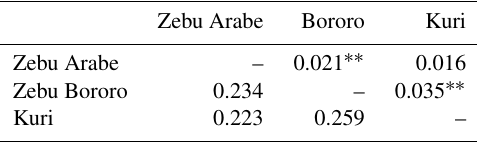
Figure 1. Distribution of allele sharing distance (IBS) between pairs of individuals. Distance was plotted separately where pairs were drawn from within the same breed (blue bars) and from across the breeds (red bars). Table 3. Pairwise allele sharing distance (lower triangle) and pair- wise F ST (upper triangle) among three Niger cattle